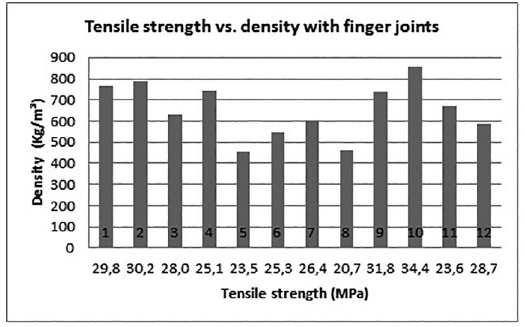
Figure 11: Chart comparing density to tensile strength for samples with finger joints.